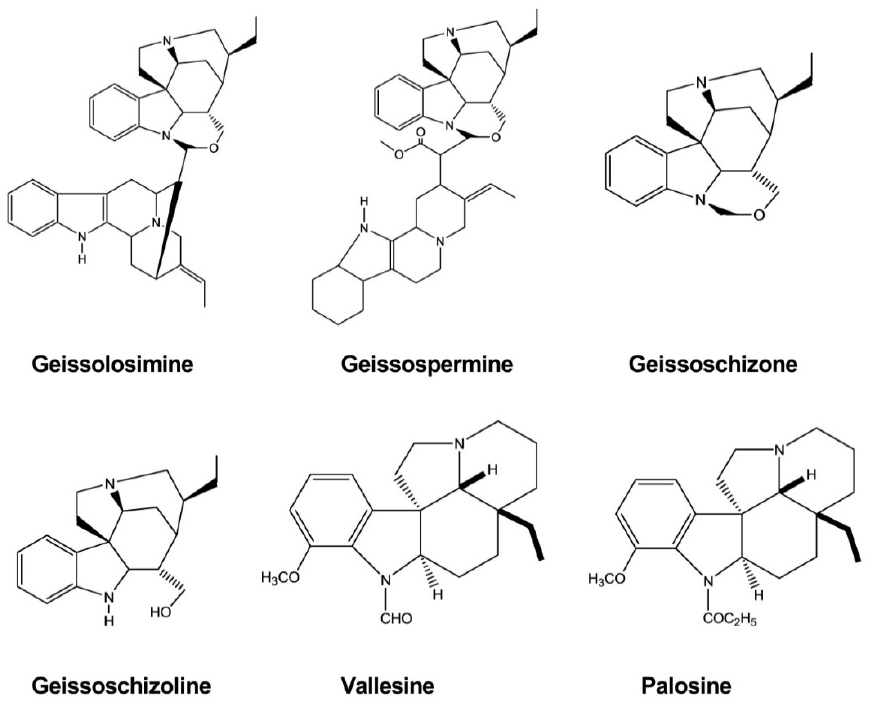
Figure 10. Antimalarial activity of indole alkaloids.